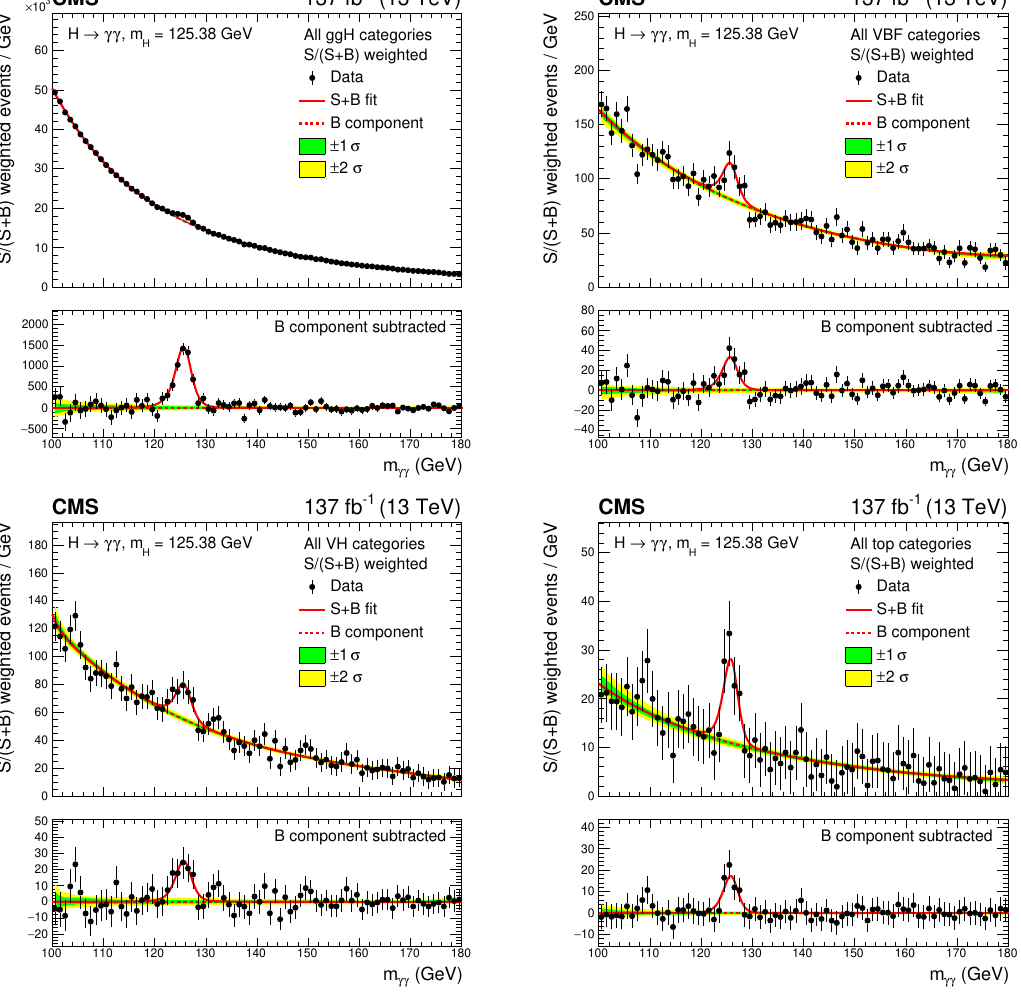
Figure 15 . The best fit signal-plus-background model with data points (black) in the fit to signal strength modifiers of the four principal production modes. The model is shown separately for groups of analysis categories targeting the ggH (upper left), VBF (upper right), VH (lower left) and top quark associated (lower right) production modes. Here, the analysis categories in each group are summed after weighting by S/(S+B), where S and B are the numbers of expected signal and background events in a ± 1 σ window centred on m . The one standard deviation (green) m eff H gg and two standard deviation (yellow) bands show the uncertainties in the background component of the fit. The solid red line shows the total signal-plus-background contribution, whereas the dashed red line represents the background component only. The lower panel in each plot shows the residuals after subtraction of this background